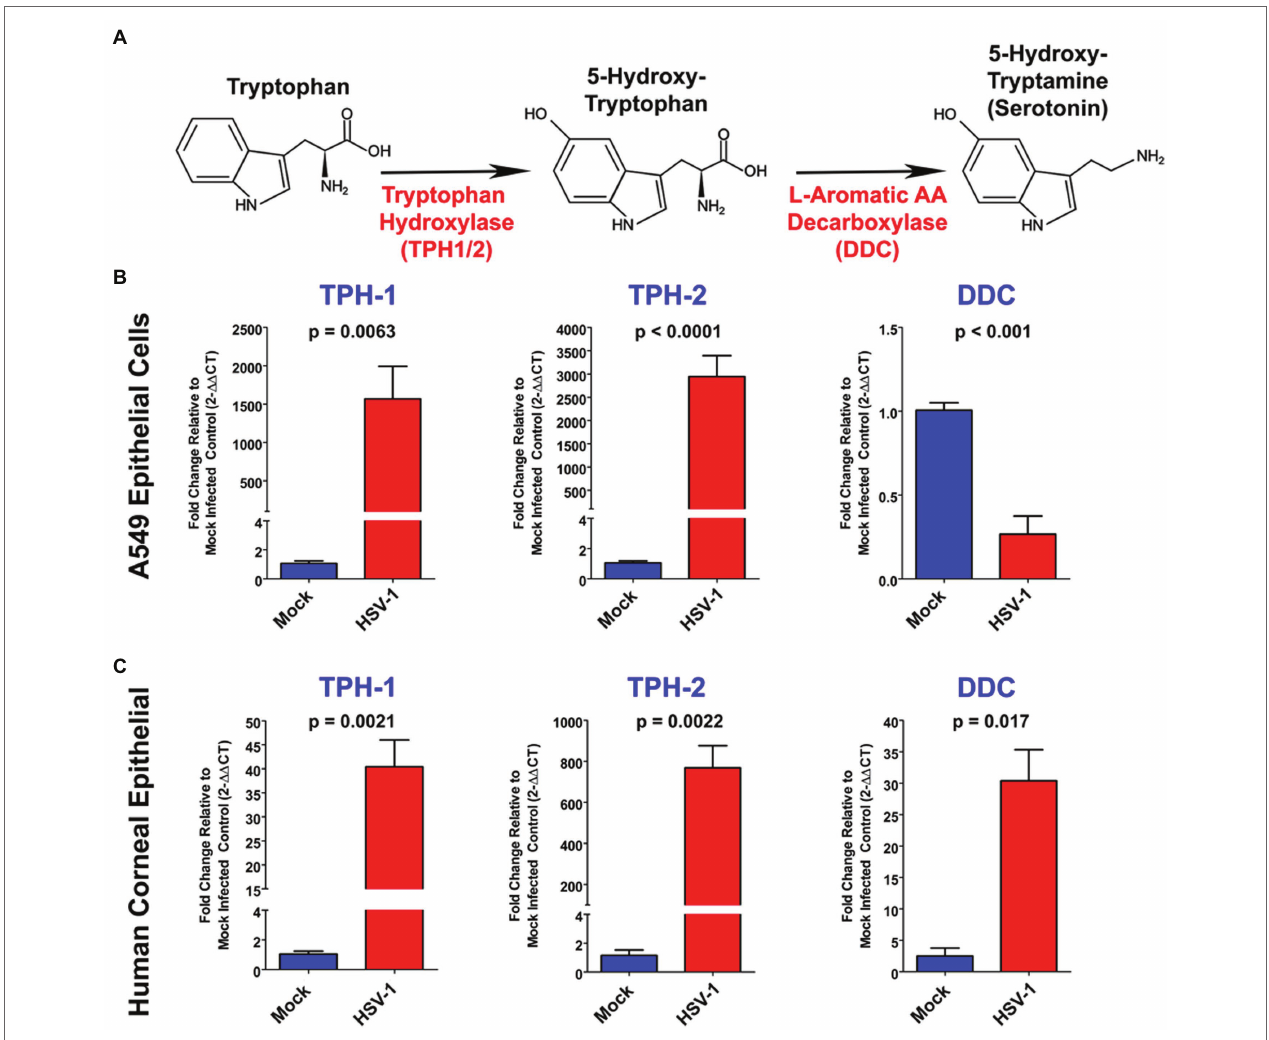
FIGURE 2 | Herpes simplex virus alters expression of key genes associated with serotonin synthesis. (A) Schematic of the serotonin synthesis pathway indicating key enzymes involved in the synthesis of serotonin from L-Tryptophan (L-Trp). (B,C) Quantitative RT-PCR analysis of TPH1 , Tryptophan hydroxylase 2 ( TPH2 ), and DOPA decarboxylase ( DDC ) relative fold change in gene expression in either A549 (B) or primary Human Corneal Epithelial Cells ( C ; HCEC ), comparing mock- infected to HSV-1 infected cells. Mock-infected values for each gene were set to 1, and relative fold change was determined by 2-DDCT method. Data are graphed as mean ±